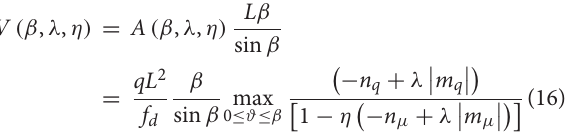
is drawn versus the colatitude θ of sections (see Figure 1 ).